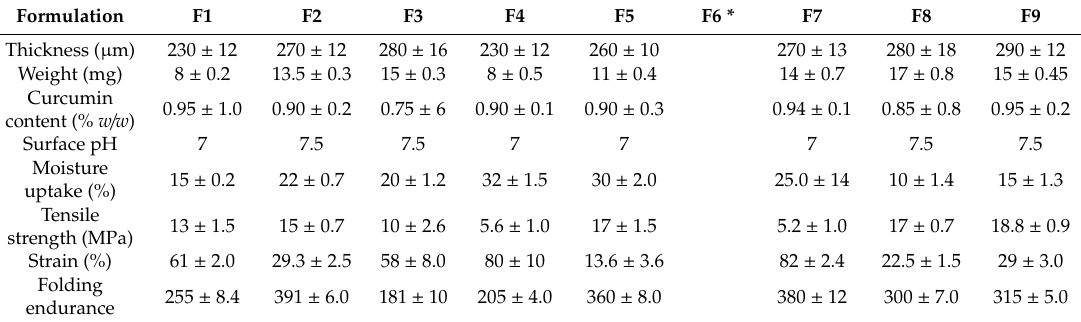
Table 2. Dimensions, drug content, moisture uptake (%), tensile strength, strain and folding endurance for curcumin insert, data represent mean ± standard deviation (SD), n =